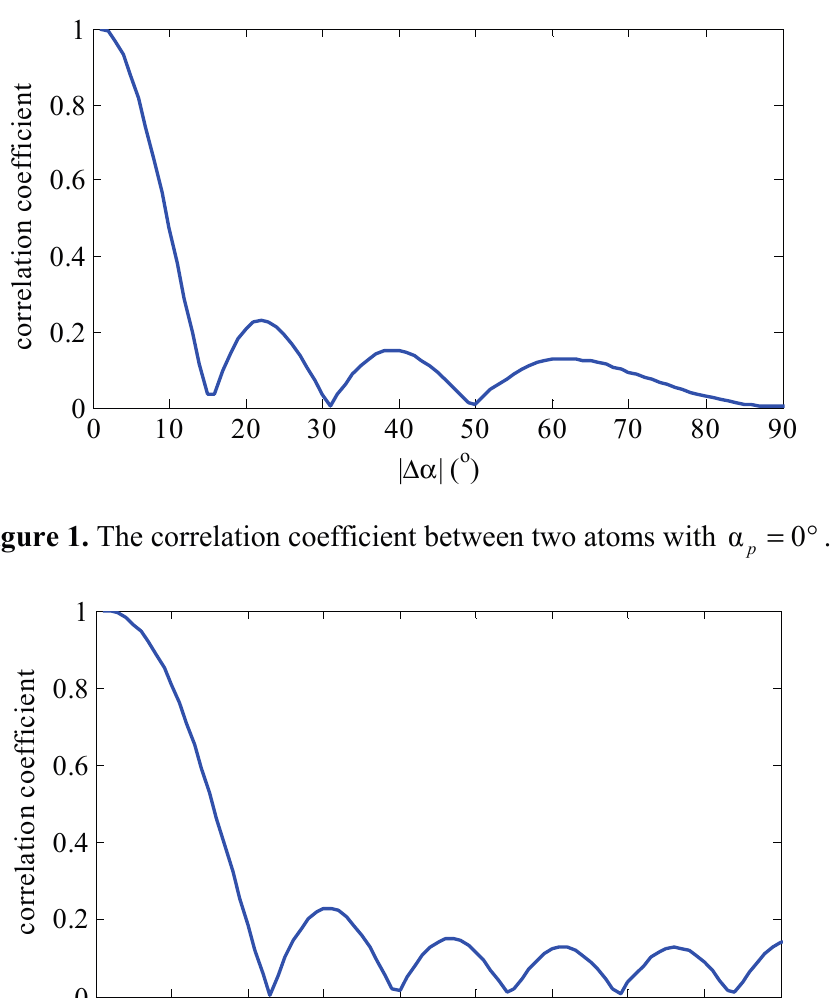
Figure 2. The correlation coefficient between two atoms with α 60